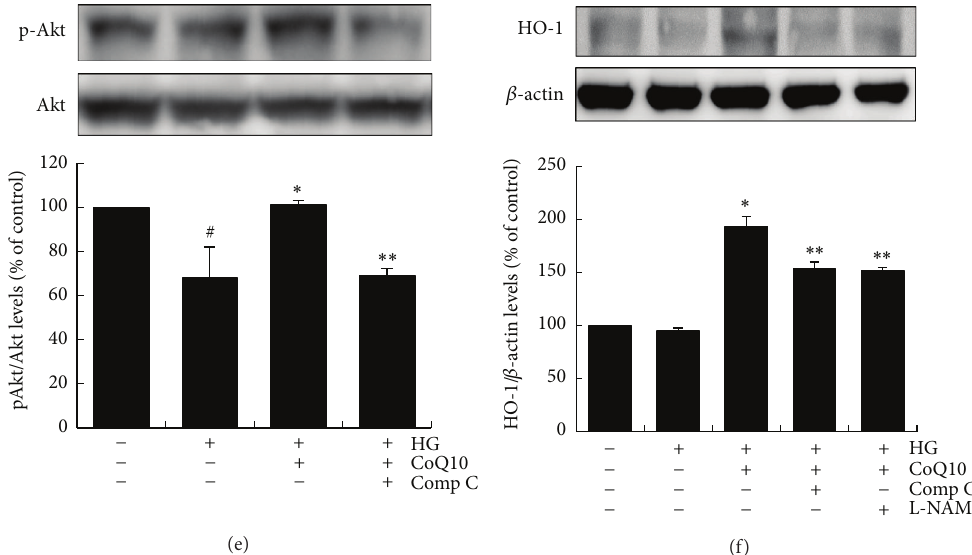
Figure 4: CoQ10 attenuates ROS and activates NO and AMPK pathway of EPCs under high glucose conditions. EPCs were incubated with CoQ10 (10 𝜇 M) under high glucose conditions. (a) AMPK protein phosphorylation levels of EPCs were analyzed by western blot. Data are mean ± SE; 𝑛 = 6 . (b) NO production of EPCs was assessed by staining with NO fluorescent indicator 3-amino,4-aminomethyl-2 󸀠 ,7 󸀠 - difluorofluorescein (DAF-FM) diacetate (10 𝜇 M) for 30 min. (c) ROS production of EPCs was assessed by staining with DCFH-DA (10 𝜇 M) for 20 min. The fluorescence intensity was measured using a fluorescent microplate reader. ((d), (e), and (f)) Expressions of Akt protein phosphorylation, eNOS protein phosphorylation, and HO-1 protein were assessed by western blot analysis. Comp C: component C, AMPK inhibitor; L-NAME, NO inhibitor. Data are mean ± SE; 𝑛 = 4 ; # 𝑃 < 0.05 versus control (5mM glucose); ∗ 𝑃 < 0.05 versus high glucose (HG); ∗∗ 𝑃 < 0.05 versus